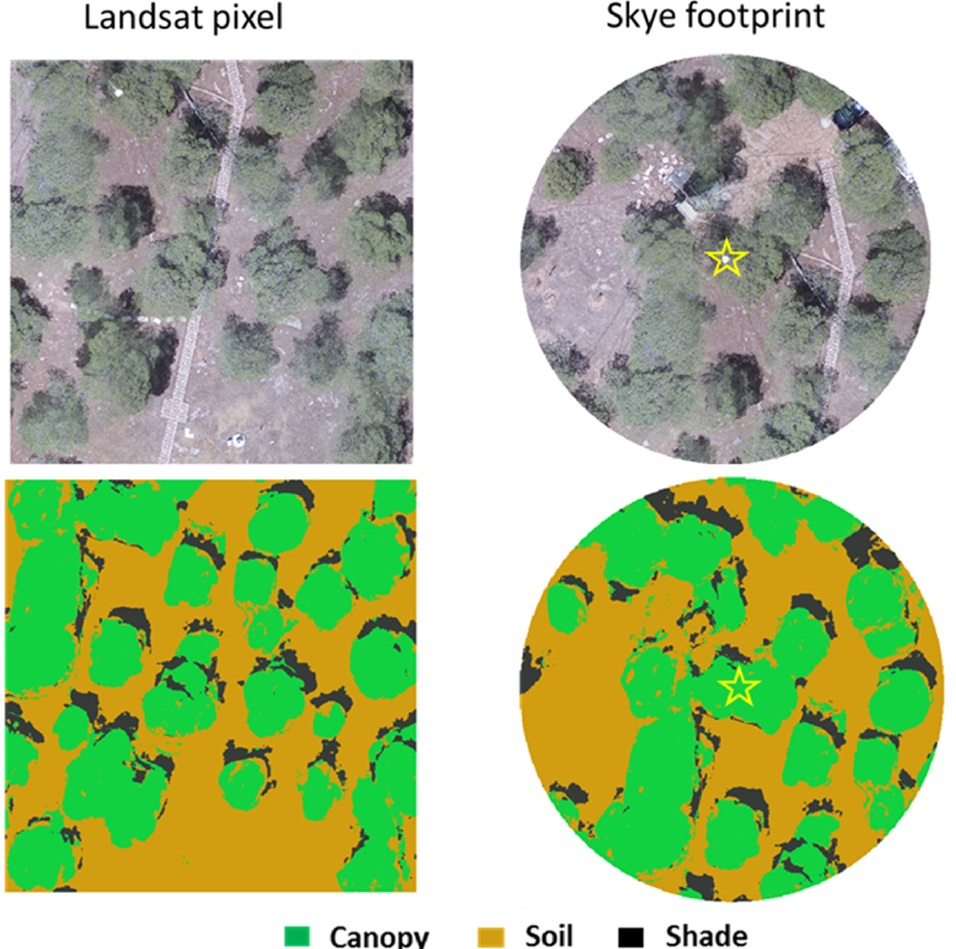
Figure 3. An example of image classification using UAV multispectral images at 13:00 local time on 25 June 2019, compared with the RGB image. The left column shows the Landsat 8 pixel (30 × 30 m 2 ). The right column shows the Skye footprint area, with a radius of 15 m, and the star indicates the sensor location. Canopy, shade, and soil are shown in green, black, and brown, respectively.